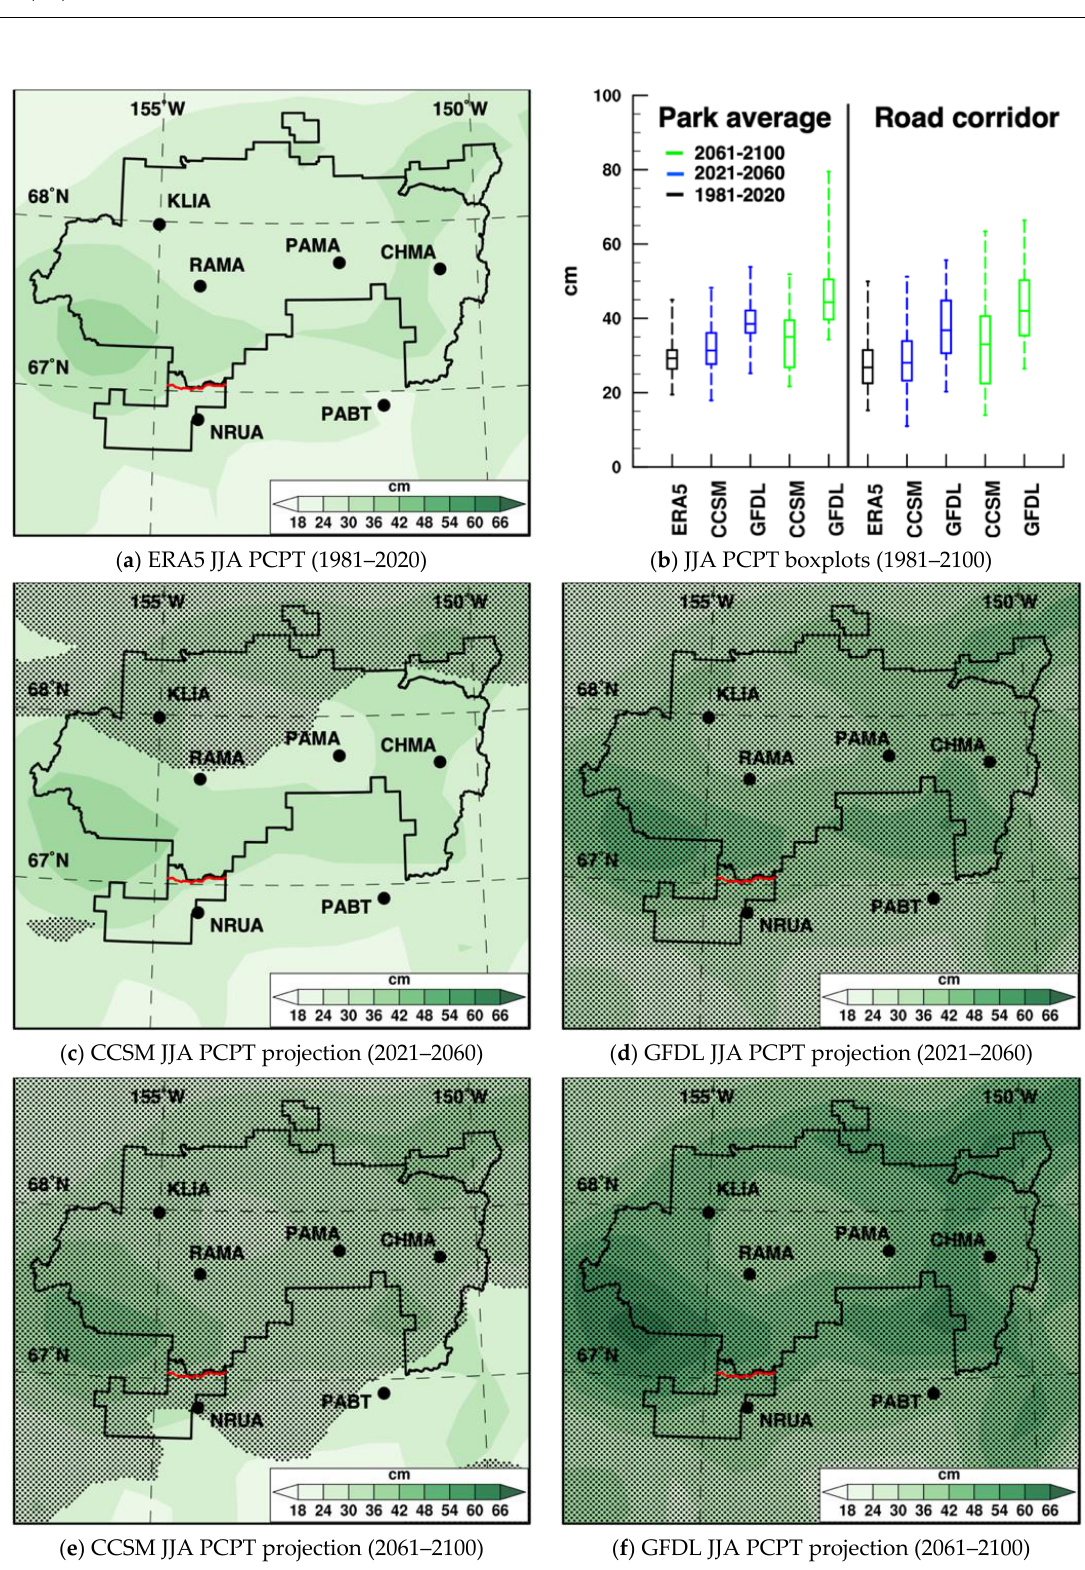
Figure 7. Gates of the Arctic ( a ) ERA5 summer precipitation (JJA PCPT) climatology (cm), ( b ) park- average (left) and road corridor (right) boxplots of MAAT, and bias-corrected: mid-century MAAT projections from ( c ) CCSM and ( d ) GFDL and late-century MAAT projections from ( e ) CCSM and ( f ) GFDL. Projected changes at the 95% confidence level are shaded with stippling.